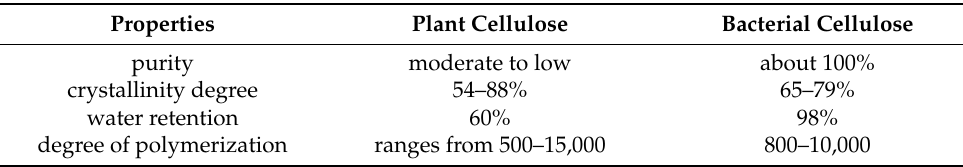
Table 1. The differences between plant cellulose and bacterial cellulose. Properties